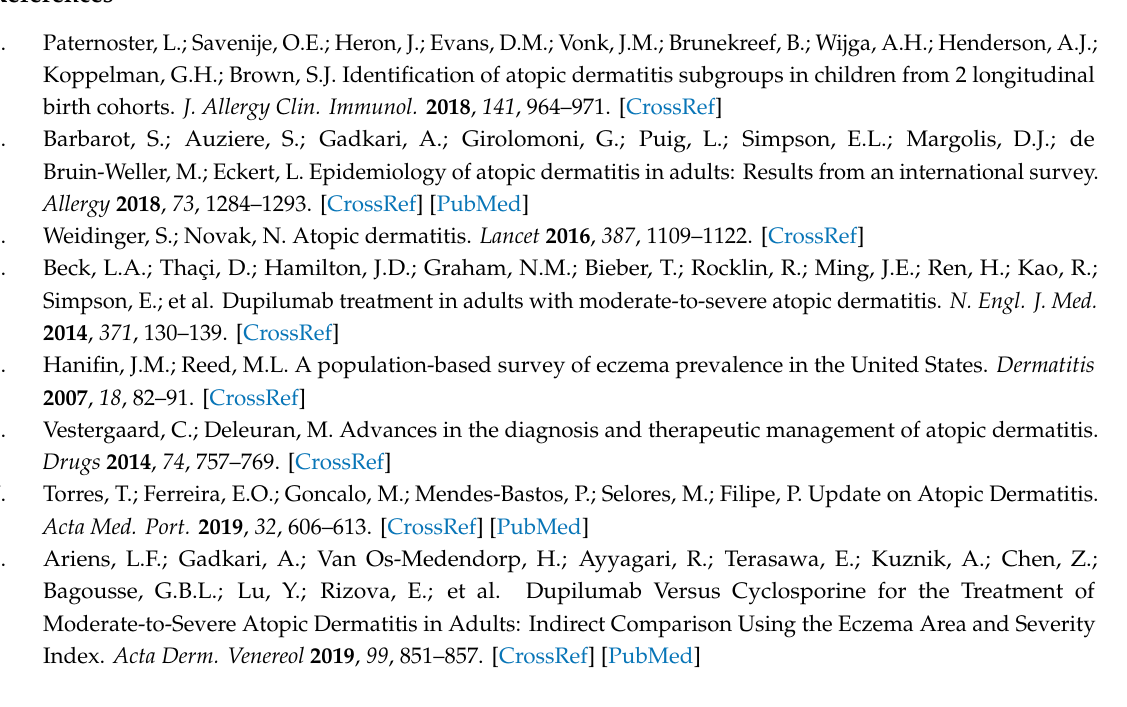
Figure S1: E ff ectiveness of Dupilumab: Eczema Area and Severity Index (EASI) 50, 75, and